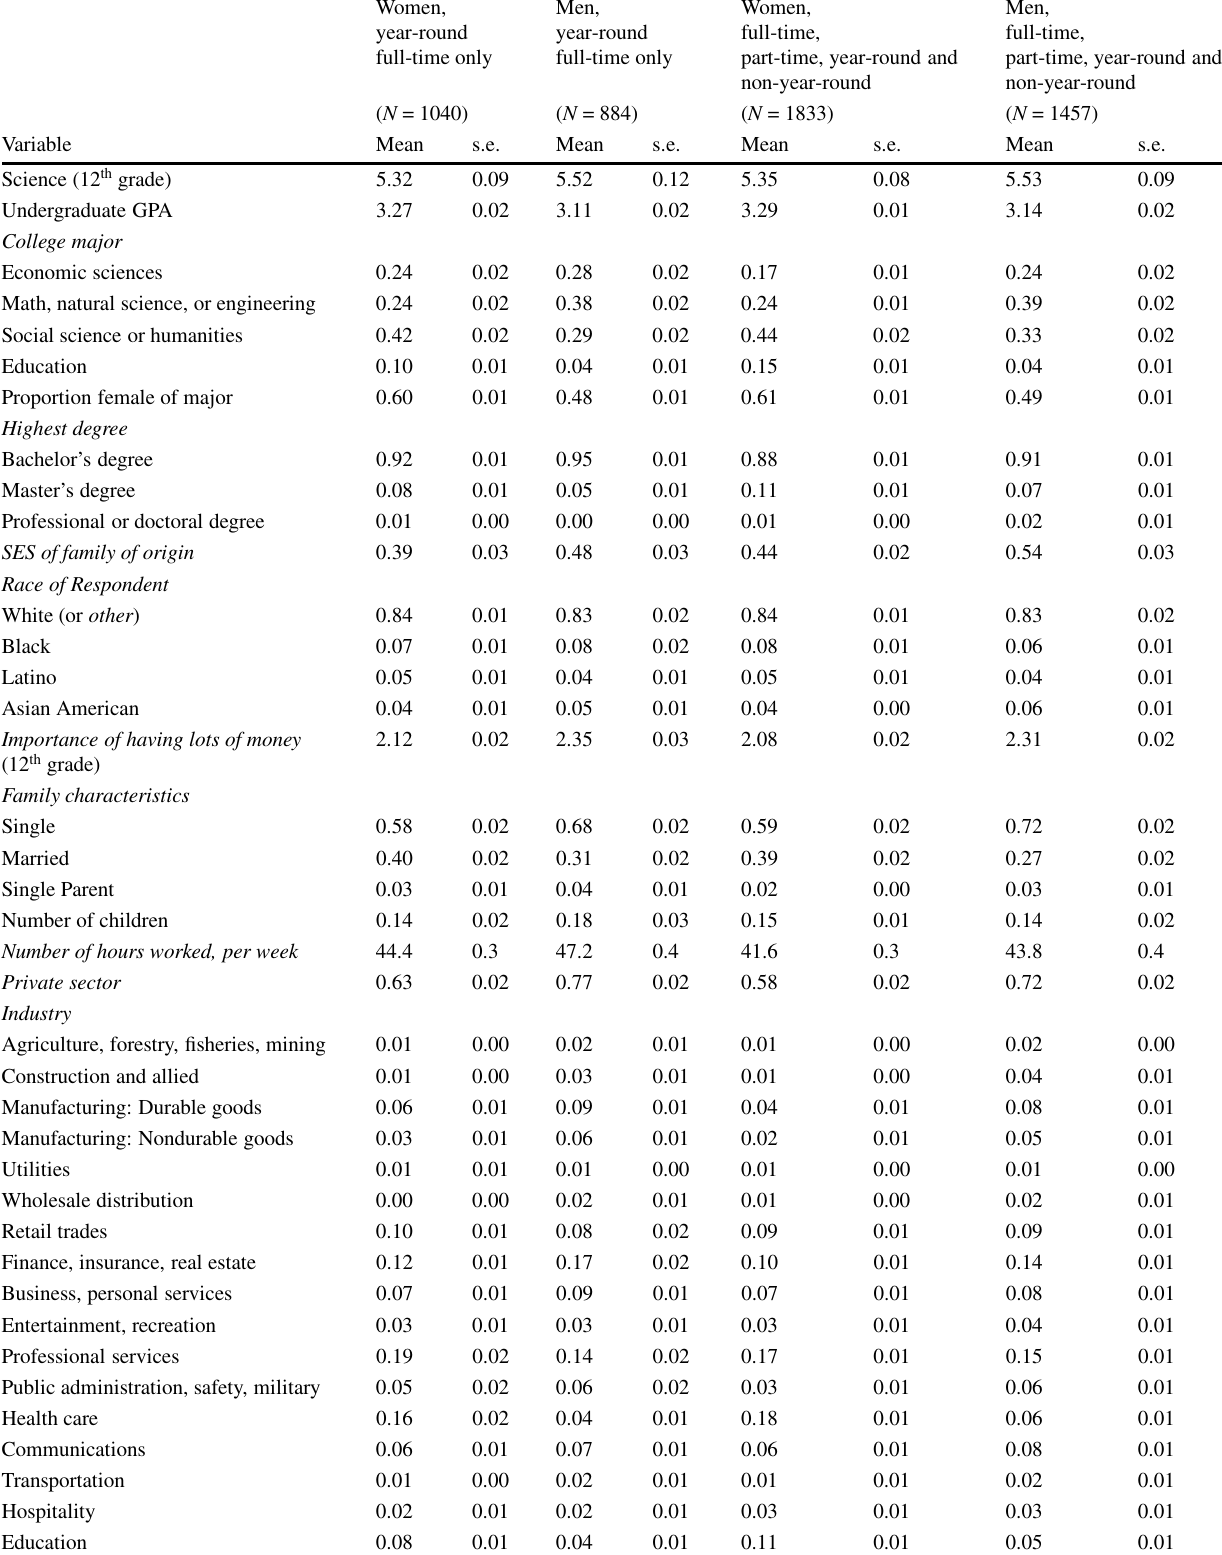
Table 3 Descriptive statistics by gender and sample definition